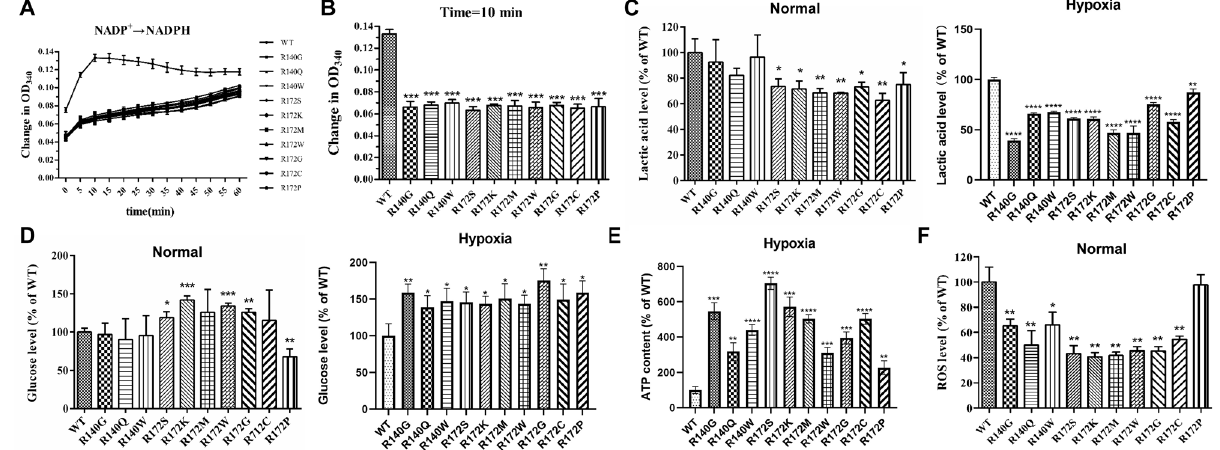
Figure 3. Analysis of the enzymatic activity of the mutated IDH2 protein from total 293T cell lysates at 48 h posttransfection. ( A ) The oxidative activity of IDH2 was determined by monitoring the increase in the absorbance of NAPDH at 340 nm over a period of 60 min on a Thermo Scientific Microplate Reader. ( B ) Assay of the maximum IDH2 activity in the tenth minute. Data were normalized to the IDH2 WT group and represent the mean values (± SD) from quadruplicate measurements. Statistically significant differences between WT and mutants are presented as *** p < 0.001. ( C , D ) Changes in intracellular lactic acid and glucose levels were determined under normal and hypoxic conditions by using lactic acid and glucose assay kits. The changes in the absorption value at 505 nm (glucose) or 530 nm (lactic acid) were measured by UV spectrophotometry. Statistically significant differences between WT and mutants are presented as * p < 0.05, ** p < 0.01, *** p < 0.001, **** p < 0.0001. ( E ) ATP levels were measured in 293 T under hypoxia conditions by using the ATP Detection Kit and Luminometer at 48 h post-transfection with IDH2 WT and mutation constructs. Data were normalized to WT and represent the mean values (± s.d.) of triplicate cultures. All the assays were performed from triplicate experiments. Statistically significant differences between WT and mutants are presented as ** p < 0.01, *** p < 0.001, **** p < 0.0001. ( F ) ROS levels were measured under normal conditions by using a Reactive Oxygen Species Assay Kit and a fluorospectrophotometer. The oxidative conversion of cell permeable dichlorofluorescein diacetate (DCFH-DA) to fluorescent dichlorofluorescein (DCF) indicates changes in intracellular ROS levels. Statistically significant differences between wild-type and mutations are presented as * p < 0.05, ** p < 0.01, *** p < 0.001. All assays were performed in